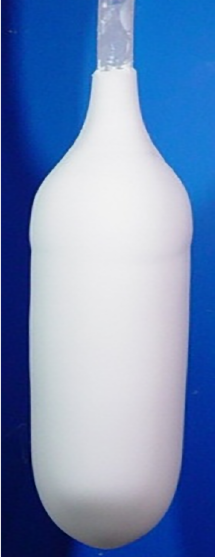
Figure 2. Green body formed by agglomerated silica nanoparticles synthesized by VAD.